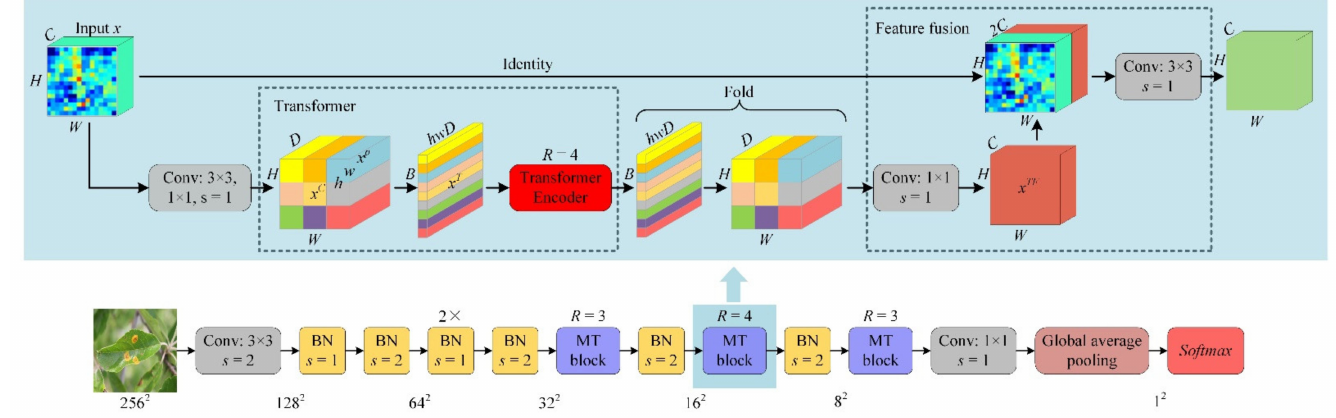
Figure 7. Hybrid model of CNN and Transformer. s represents stride, 2 × means repeat twice, MT block is the abbreviation of Mobile-Transformer block, which represents the combination of CNN and Transformer and BN represents the Inverted Residual Block in MobileNet-V2. In MT module, the feature map of H × W is divided into B patches, then B patches are expanded and sent to the layer composed of R Transformer Encoder in series. Finally, the output of Transformer Encoder is folded and the attention embedding and feature fusion are